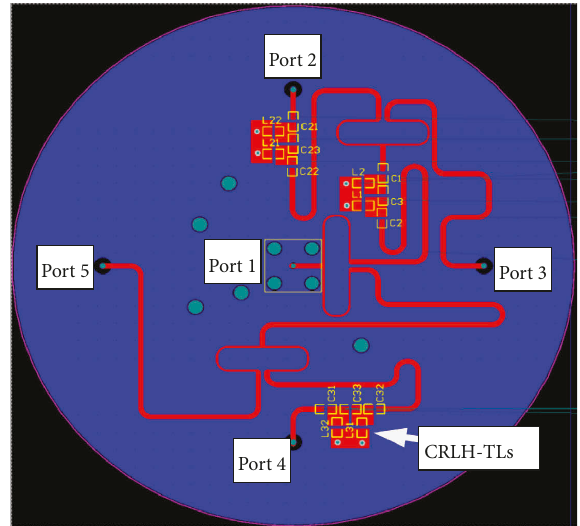
Figure 3: PCB structure of the power division phase shifting